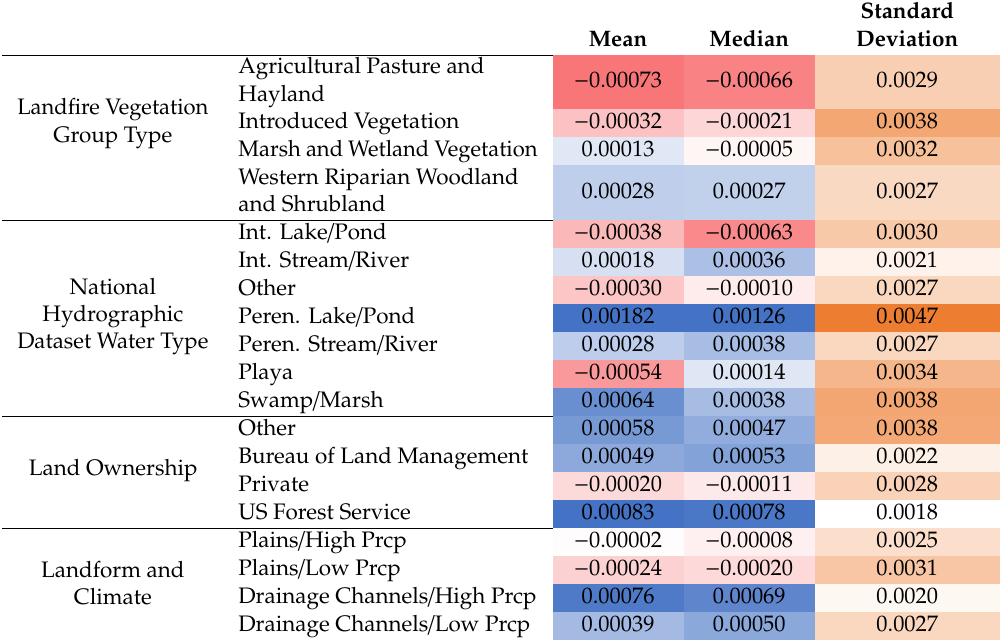
Table 2. Descriptive statistics of Sen’s slope distributions by vegetation type, hydrography, land ownership, and landform / climate. Red (blue) shading corresponds with negative (positive) central tendencies. Orange shading indicates magnitude of standard